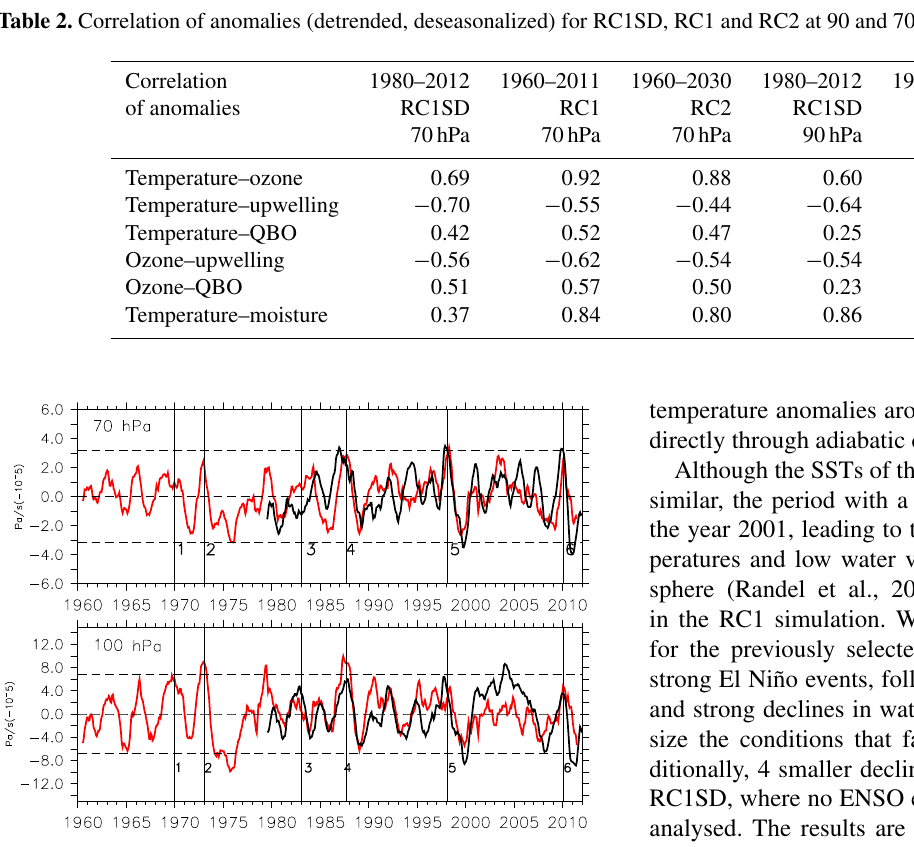
Figure 10. Temporal evolution of tropical upwelling anomalies in the tropics (20 ◦ S–20 ◦ N) (deseasonalized and detrended) at 70 and 100hPa (running mean). Red lines indicate data derived from RC1, black lines from RC1SD. Black dashed lines mark one standard deviation from the unsmoothed RC1SD monthly mean upwelling anomaly values. Black solid vertical lines mark El Niño events sim- ilarly to Fig.